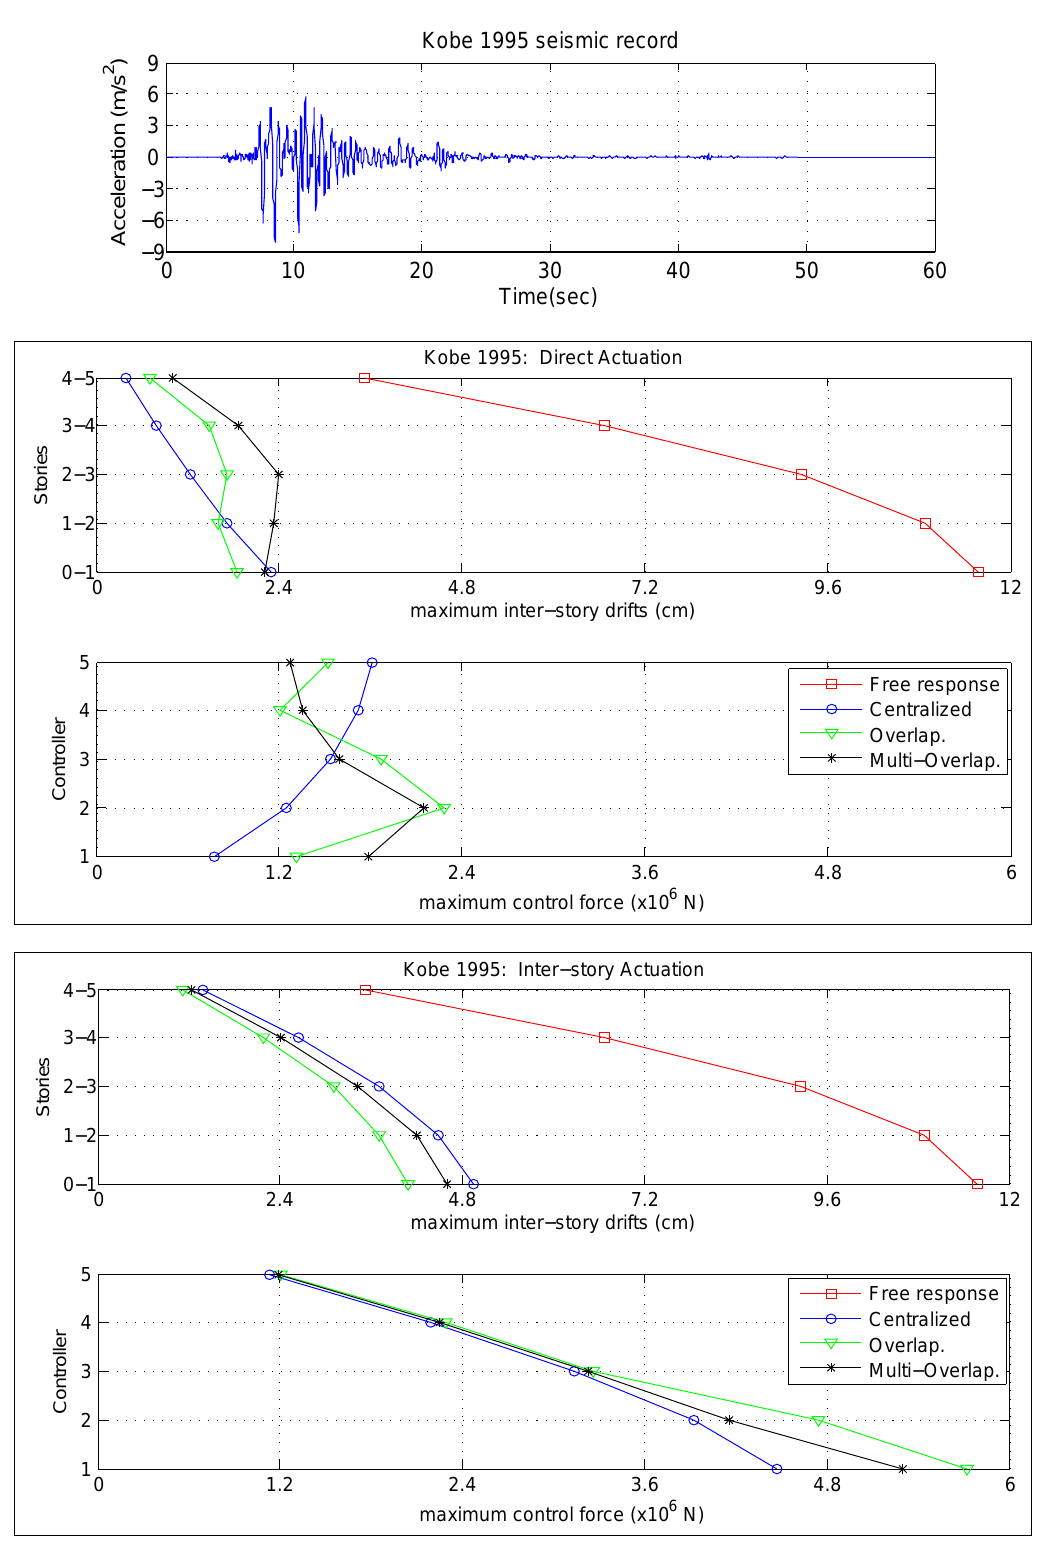
Figure 13: Kobe 1995 seismic record. Maximum inter-story drifts and control